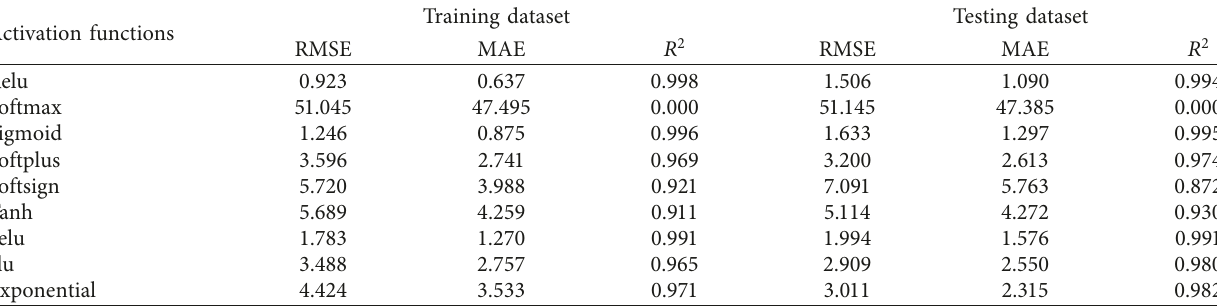
Table 7: Comparison of performance using different activation functions for Vbmax prediction on the training and testing dataset.